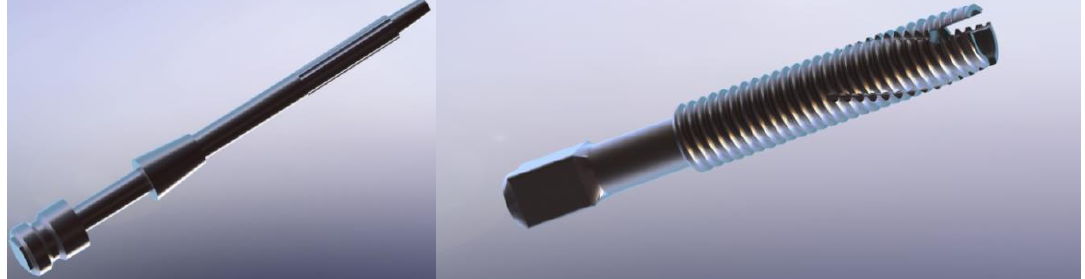
Figure 5. CAD models of the prosthetic implants analysed: OPL (on the left ) and OPRA (on the right ).